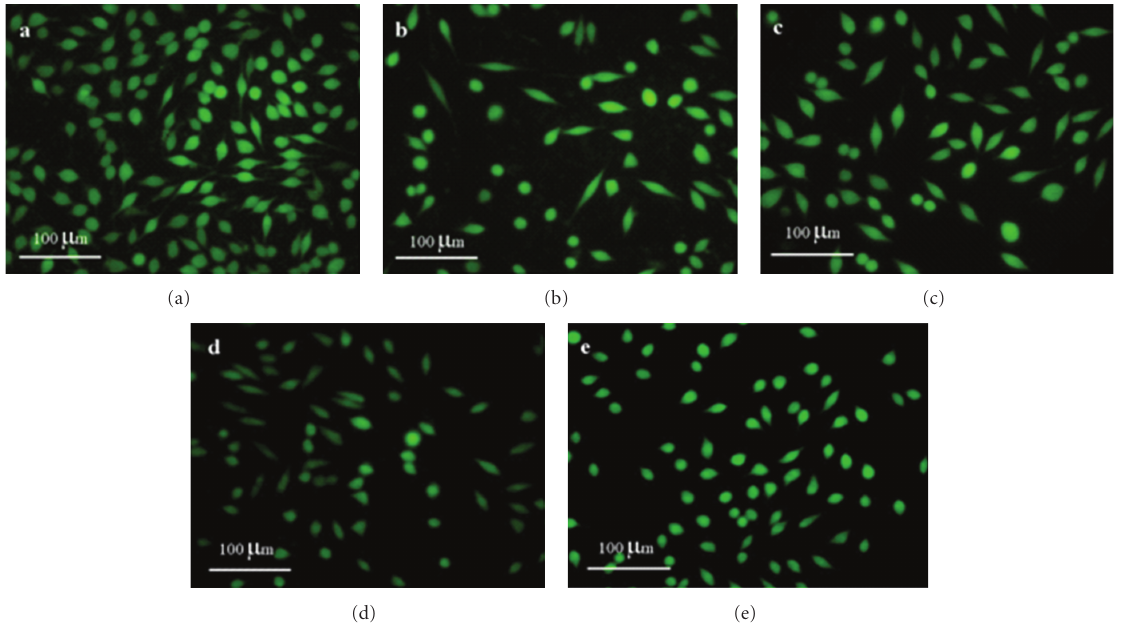
Figure 7: Morphology of L929 fibroblast cell attached on (a) F-DLC 2:1, (b) F-DLC 1: 1, (c) NiTi, (d) CP Ti, and (e) Ti-6Al-4V captured by fluorescence microscope using a 40x objective lens.